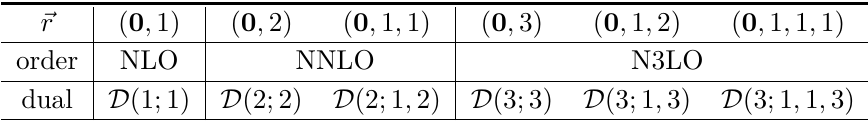
, t ) required for implementing a n − 1